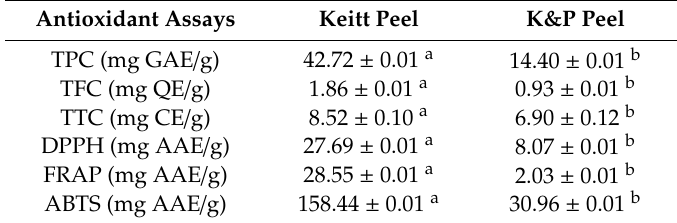
Table 1. Polyphenol content and antioxidant activity detected in mango